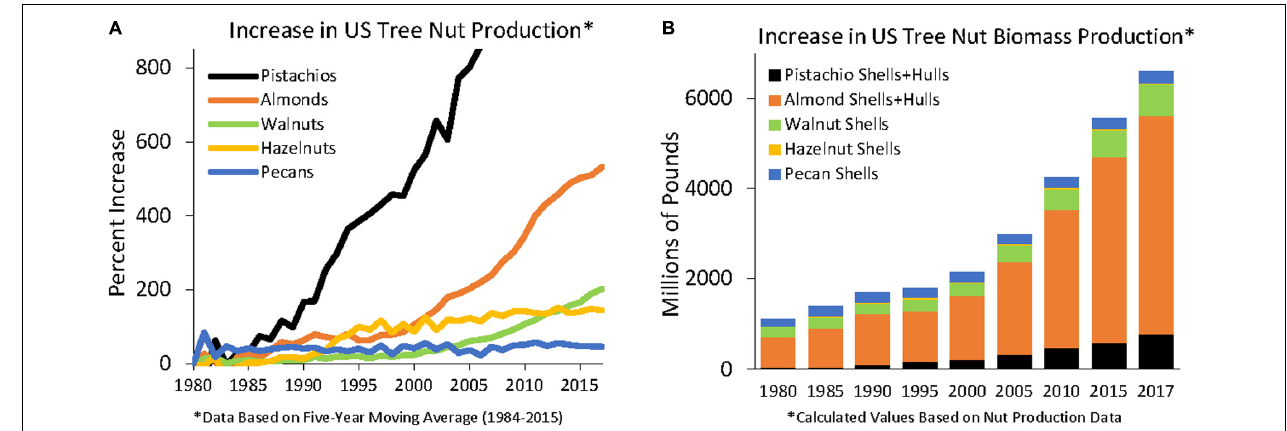
FIGURE 1 | Increases in US (A) tree nut production, in relative terms, ∗ Data based on 5 year moving average and (B) total biomass since 1980 ∗ Calculated values based on Nut Production data (USDA-ERS, 2018).